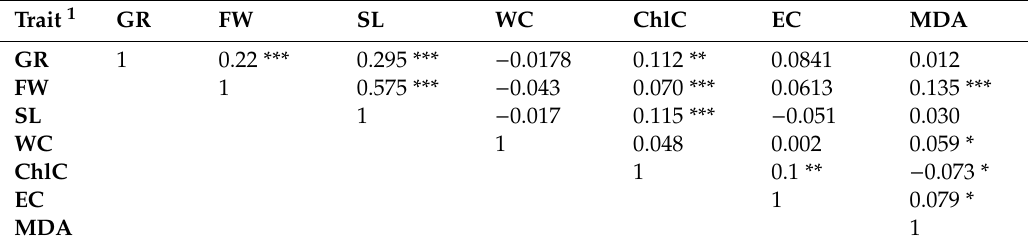
Table 2. Analysis of traits related salt treatment of G. arboretum accessions (Pearson correlation